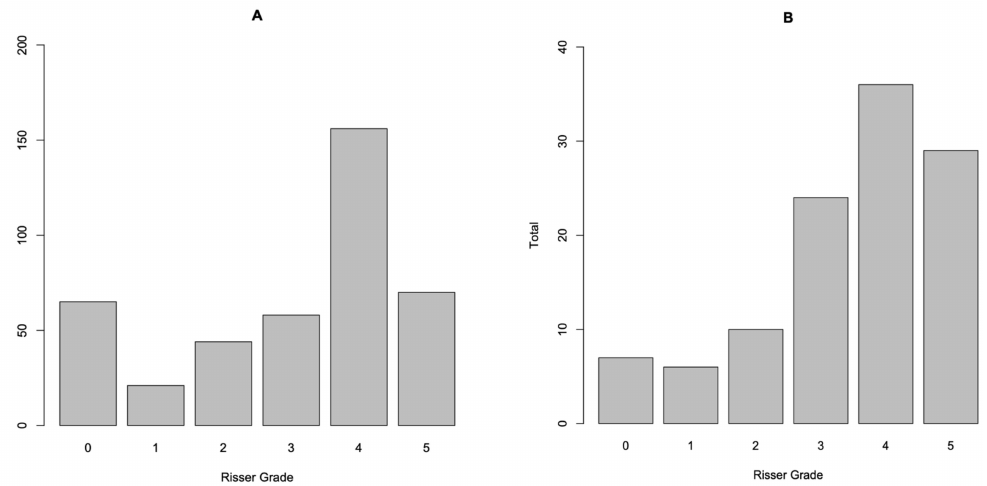
Figure 1. ( A , B ) The number of individuals for each Risser grade at presentation for both females ( A ) and males ( B